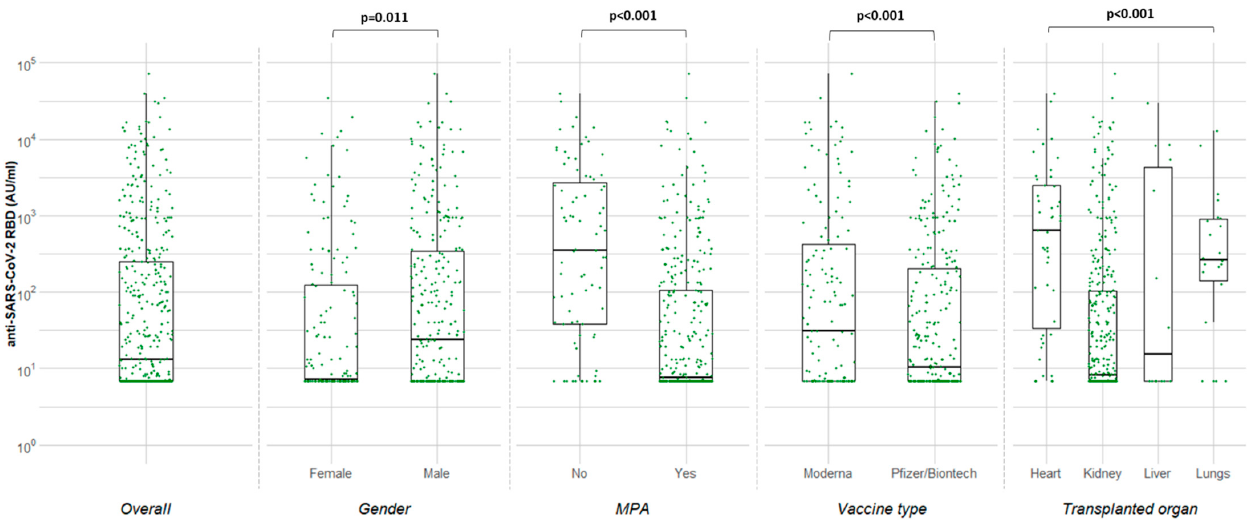
Figure 1. Median concentrations of anti-SARS-CoV-2 RBD (AU/mL) in vaccinated transplant recip- ient 15–45 days after the 2nd dose of BNT162b2 or